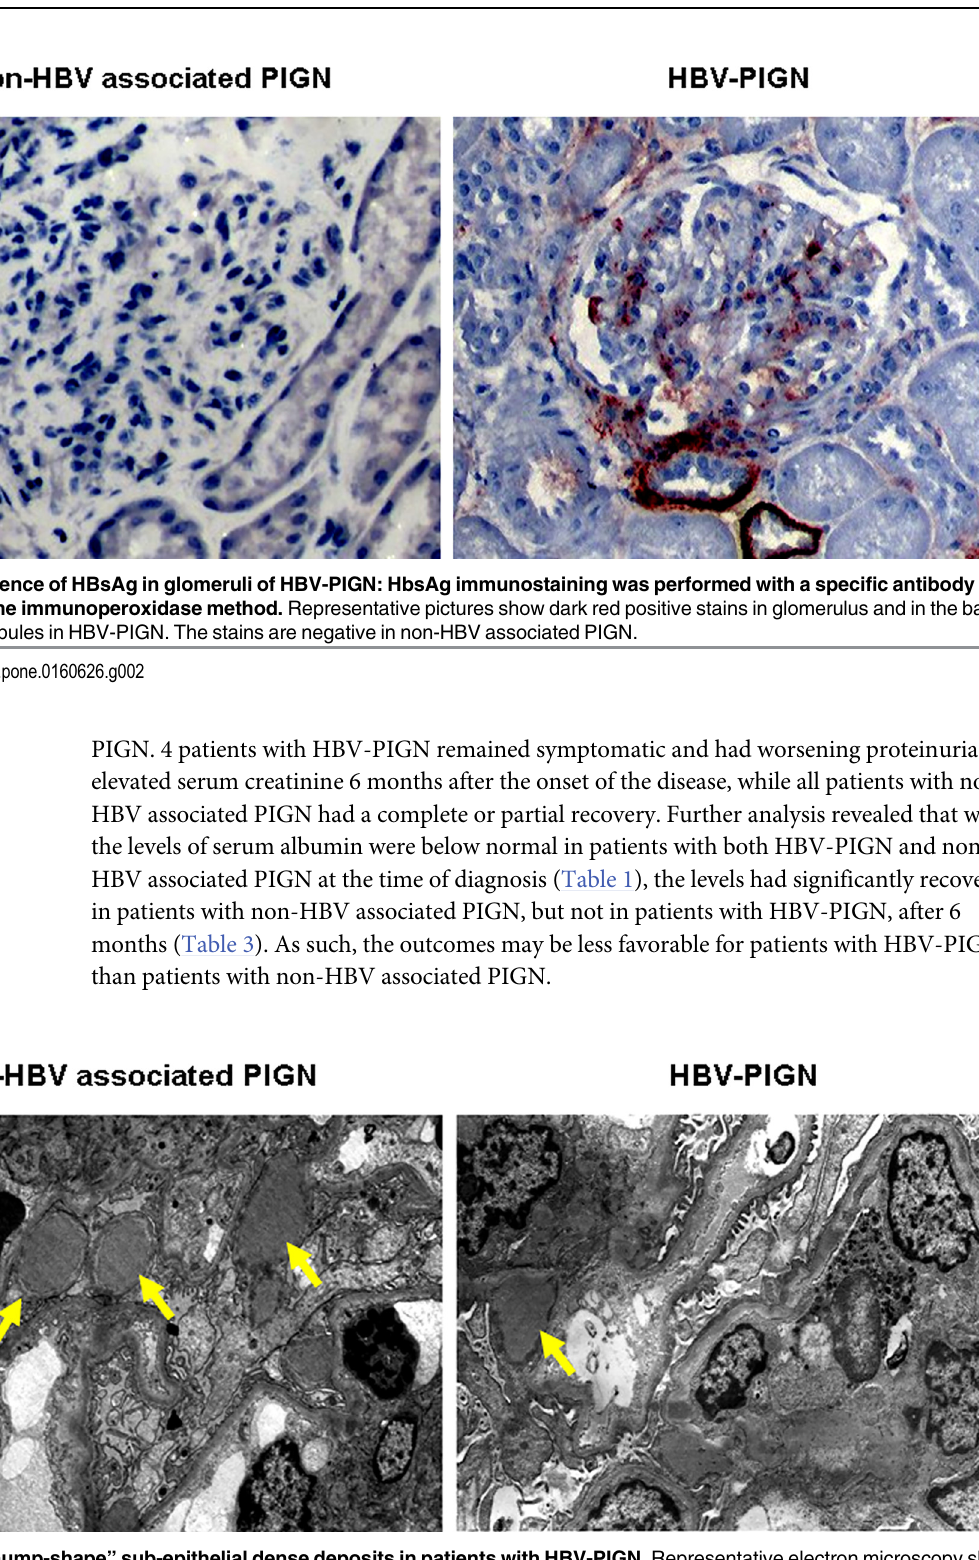
Fig 3. Fewer “ hump-shape ” sub-epithelial dense deposits in patients with HBV-PIGN. Representative electron microscopy show multiple “ hump shape ” sub-epithelial dense deposits (arrows) in non-HBV associated PIGN. The number of dense deposit is fewer in HBV-PIGN